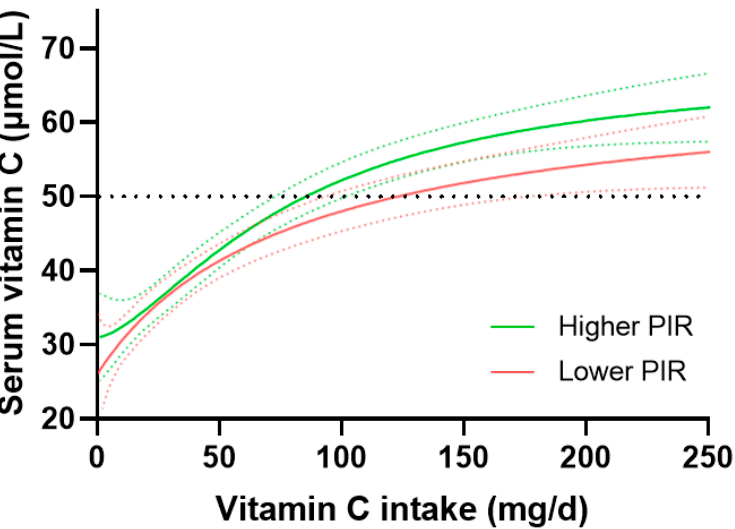
Figure 7. Vitamin C dose-response relationship relative to socioeconomic status. Higher income to poverty ratio tertile (PIR > 3.0, n = 843), and lower income to poverty ratio tertile (PIR ≤ 1.35, n = 843). Sigmoidal (four parameter logistic) curves were fitted to the dose-concentration data with asymmetrical 95% confidence intervals indicated. Dashed line indicates 50 µmol/L serum vitamin C, which is considered ‘adequate’. PIR, poverty income ratio.